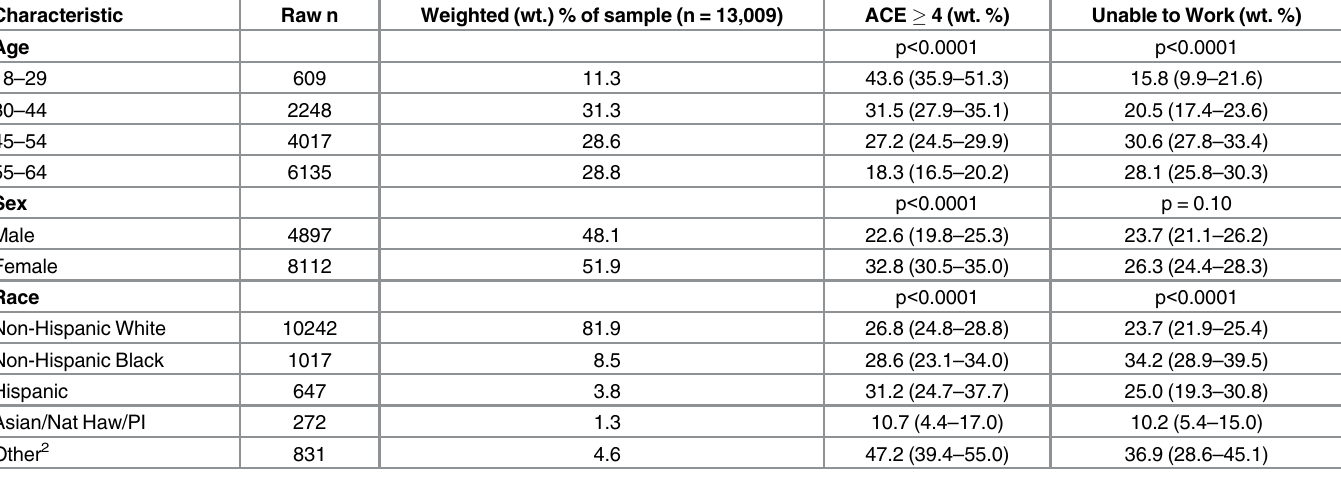
Table 2. Sample Demographics: Relationship to ACEs 1 and Perceived Work